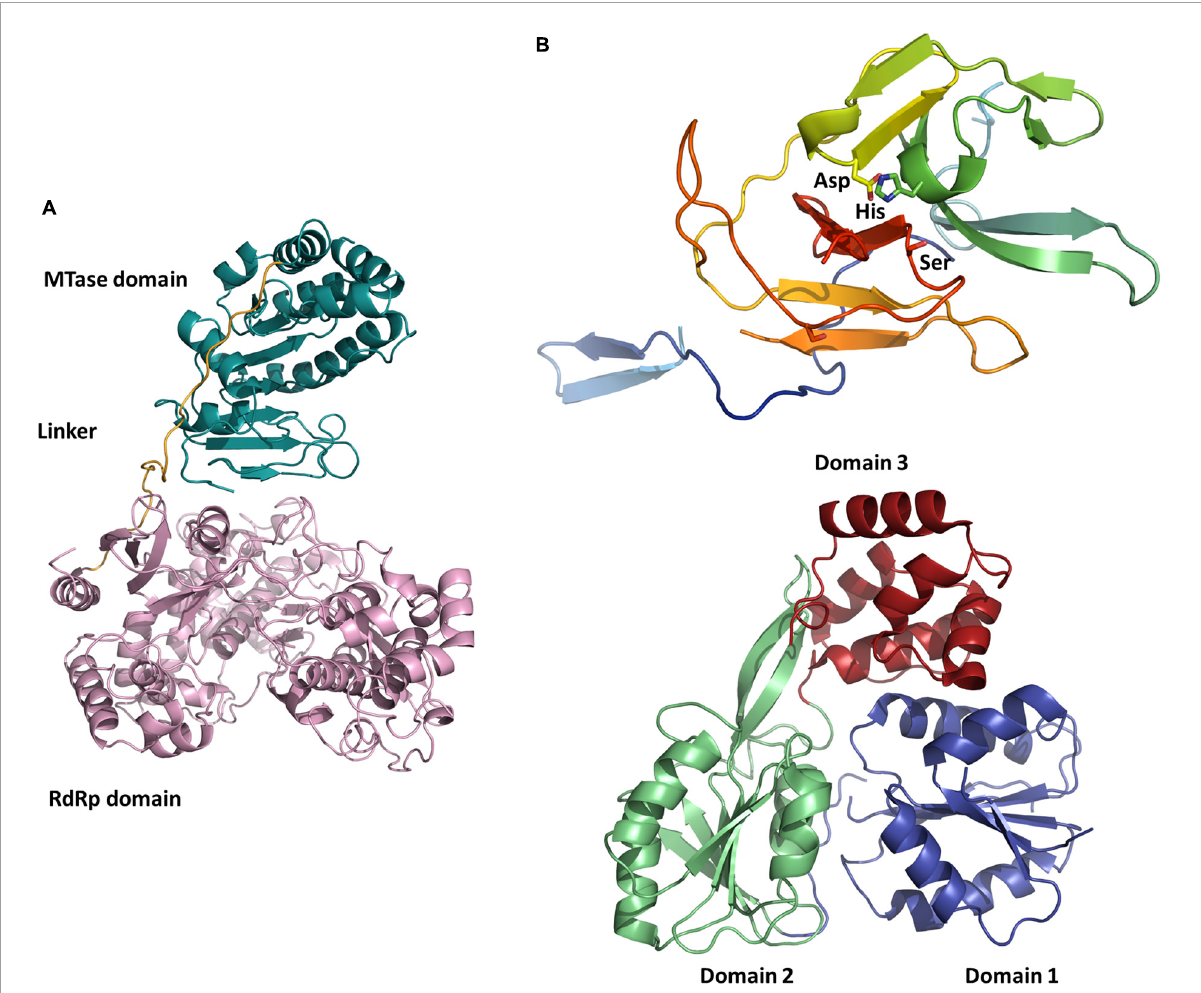
FIGURE2 Structures of NSP1 and NSP2 functional domains putatively involved in the replication. (A) Cartoon representation of the NSP1 MTase (turquoise) and RdRp (pink) domains of Guaico Culex virus (homology model). (B) Cartoon representation of the NSP2 protease domain of Jingmen tick virus (homology model) with the canonical Asp-His-Ser catalytic triad (top) and NSP2 helicase domain of Alongshan virus (PDB code 6M40, from X-ray crystallography data in Gao et al., 2020) organized in subdomains 1 (blue), 2 (green), and 3 (ochre) (bottom). All representations were prepared using PyMOL